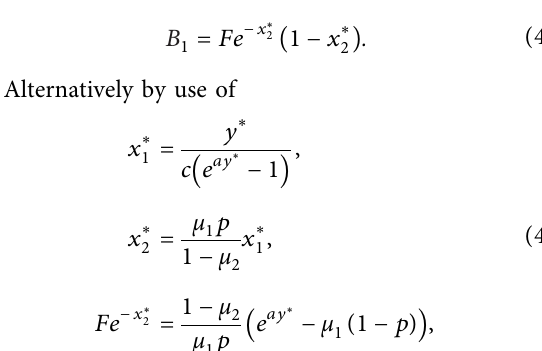
Figure 8: Values of x ∗ (b) F �